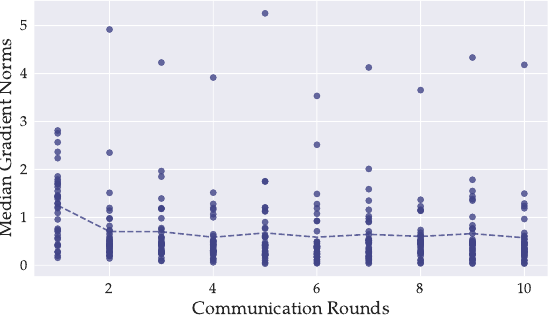
Figure A1. For each model layer in the ResNet50, we tracked the median (cid:96) 2 -norms during training of every local model. Each dot represents the mean of one layer-median over all local models. The dashed line depicts the overall mean of all per-layer (cid:96) 2 -norm medians. Most layers’ (cid:96) 2 -norms were greater during the first round of training than in later